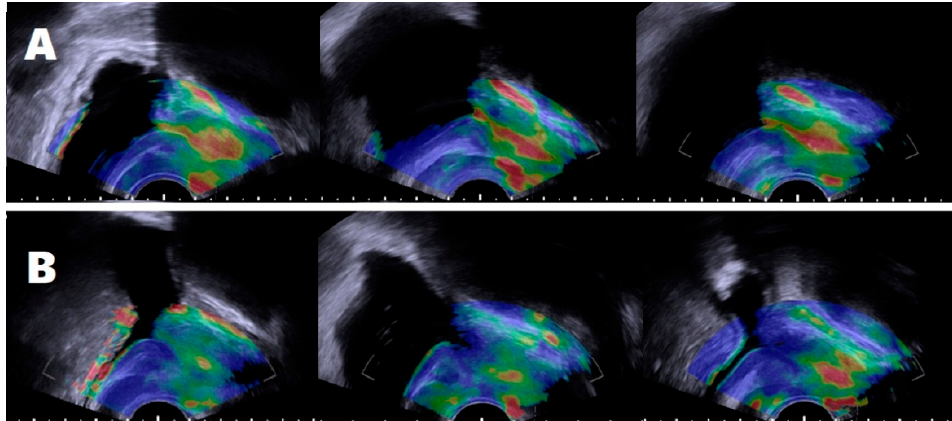
Figure 2. Two patterns of periurethral stiffness in the sagittal planes. After repeated elastography, the images of group A showed a yellow to red signal along the urethral course from the bladder neck to verumontanum ( A ) and a periurethral area easily distinguishable from the prostatic tissue. Images of group B showed a green to blue signal in the proximal prostatic urethral course ( B ), with periurethral stiffness similar to the transitional zone.